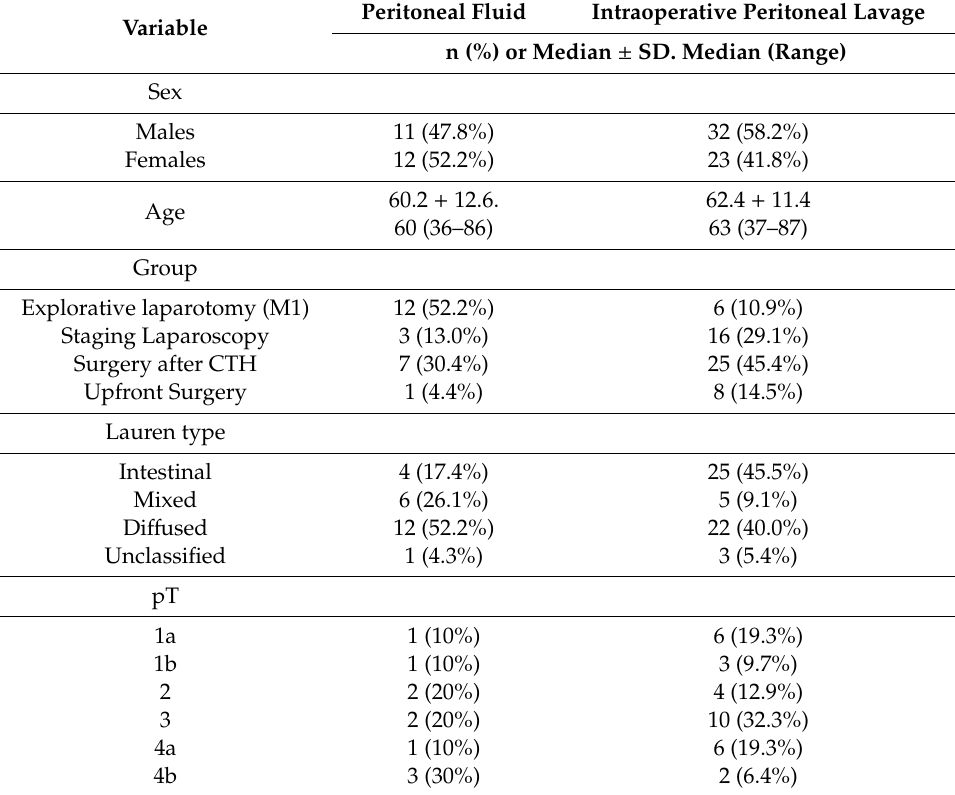
Table 1. Clinicopathological